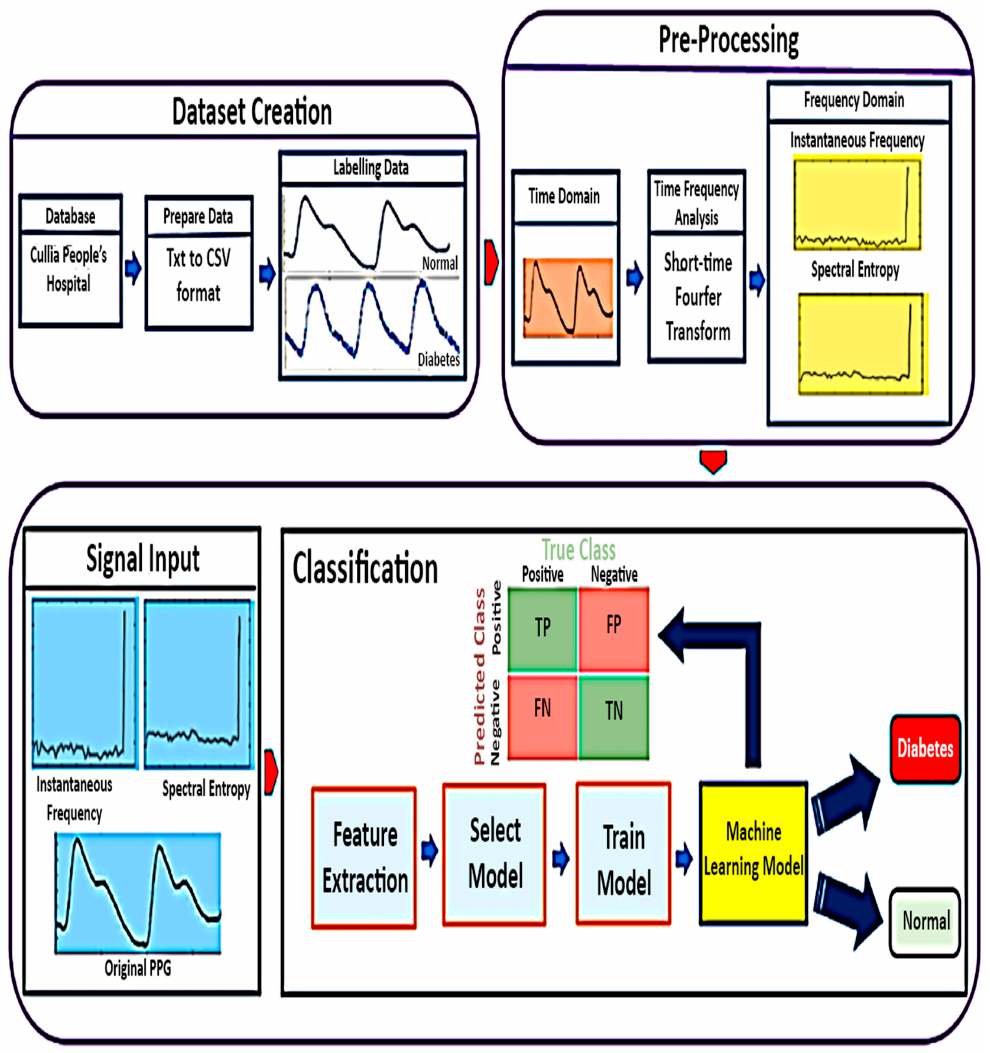
Figure 4. Block diagram representation of the suggested BGL classification approach. The three blocks represent the stages of processing: signal processing, classification results, and data collecting. There are 114 normal patients and 114 diabetics in each group’s dataset. The instantaneous frequency and spectral entropy of each PPG waveform were obtained using temporal frequency analysis and a short-time Fourier transform (STFT). A machine learning classifier was then used to classify the BGL.